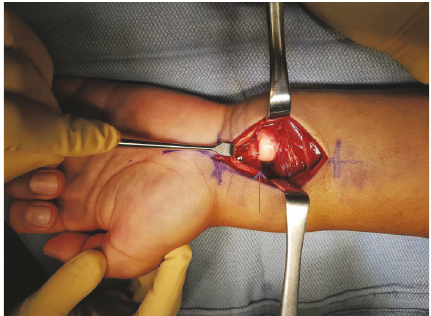
Figure 4: Repair of the distal radioulnar ligament